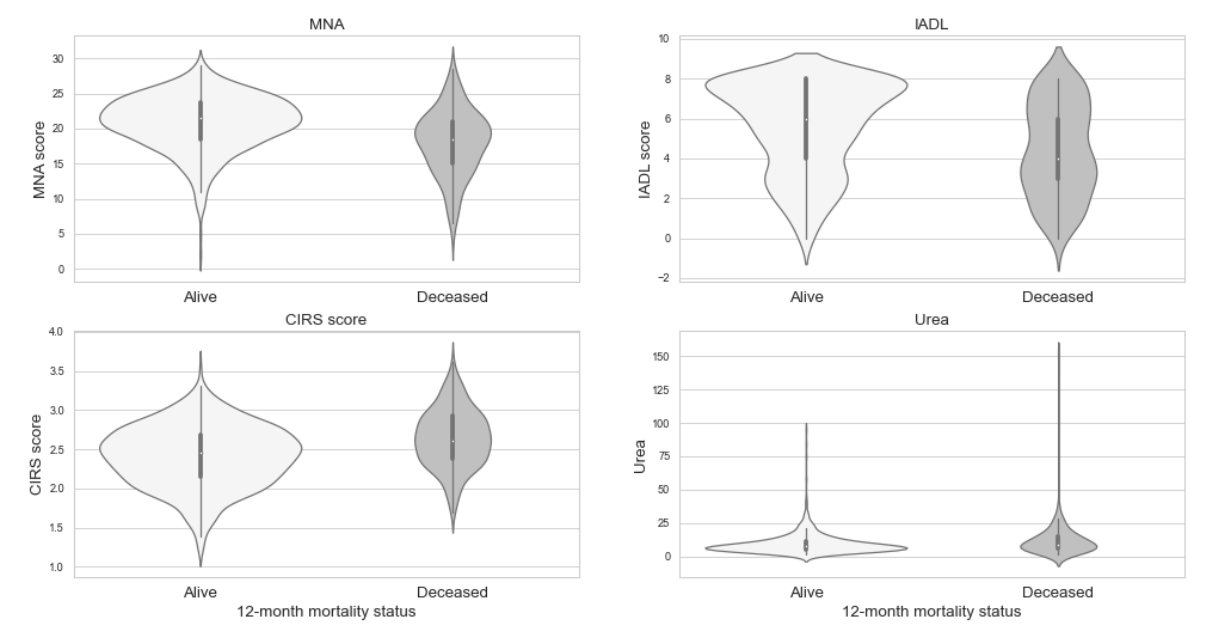
Figure 4. Violin plots showing distributions for the top 4 features for eXtreme gradient boosting in the second test feature set by patient vial status at 12 months after hospital discharge. CIRS: Cumulative Illness Rating Scale; IADL: instrumental activities of daily living; MNA: Mini Nutritional